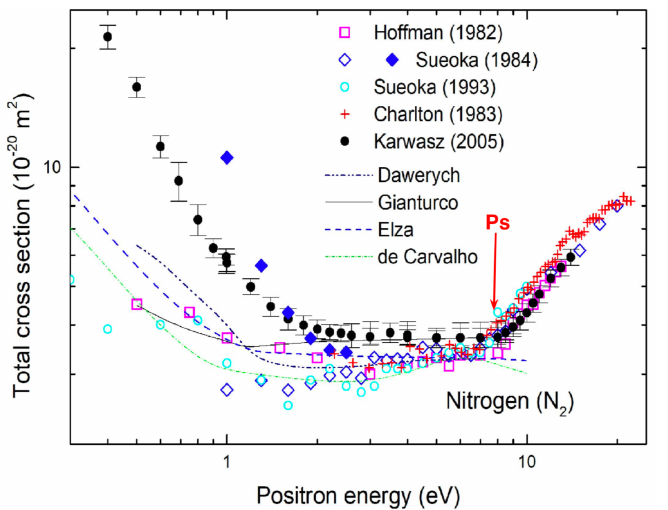
Figure 5. Total cross section for positron scattering on N 2 . All experiments (in spite of their method- ological uncertainties) indicate the rise of TCS towards zero energy (MERT domain), a flat, hard sphere-like region up to the threshold for the positronium formation (Ps—indicated by vertical arrow), and the rapid (a Wannier-like) rise of TCS above this threshold. For references see